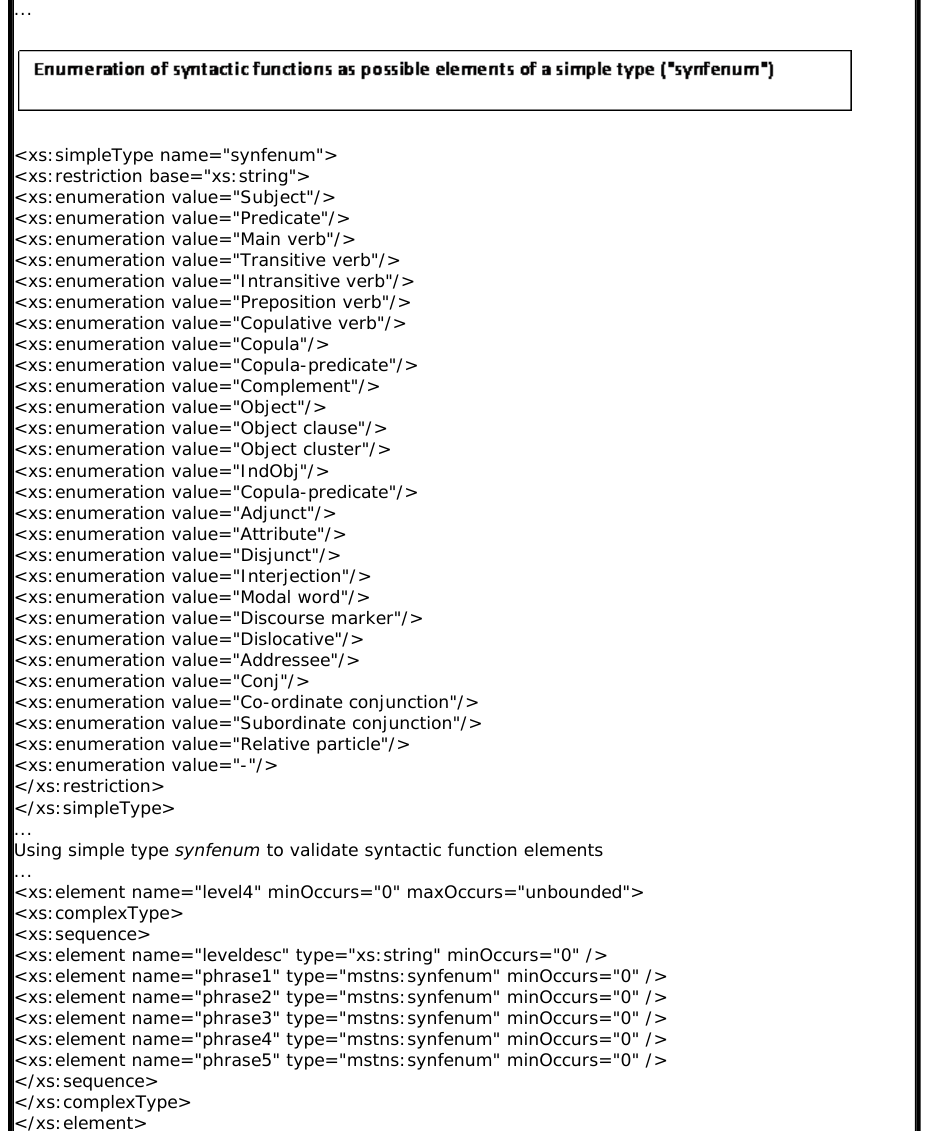
Table 1 Syntactic sections from an XML Schema used to validate an XML database of Genesis 1:1 - 2:3 ...